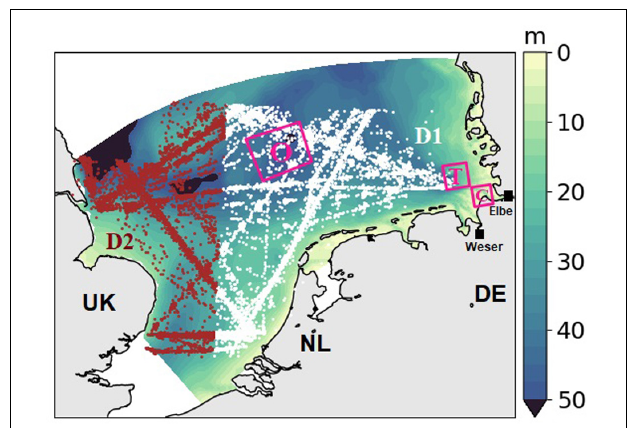
FIGURE 1 | Bathymetry of the model domain, the southern North Sea. Locations of the CPR measurements from the standard CPR area D1 (white dots) and D2 (red dots). Three pink rectangular show the selected analyzed areas, referred to as coast (“C”), transitional (“T”) and offshore (“O”). Black squares indicate the rivers Elbe and